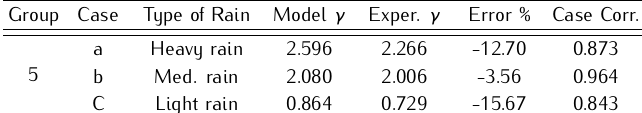
Table 20. Rain experimental data and ESLM model corrections ( λ = 1550 nm). Group Case Type of Rain Model γ Exper.